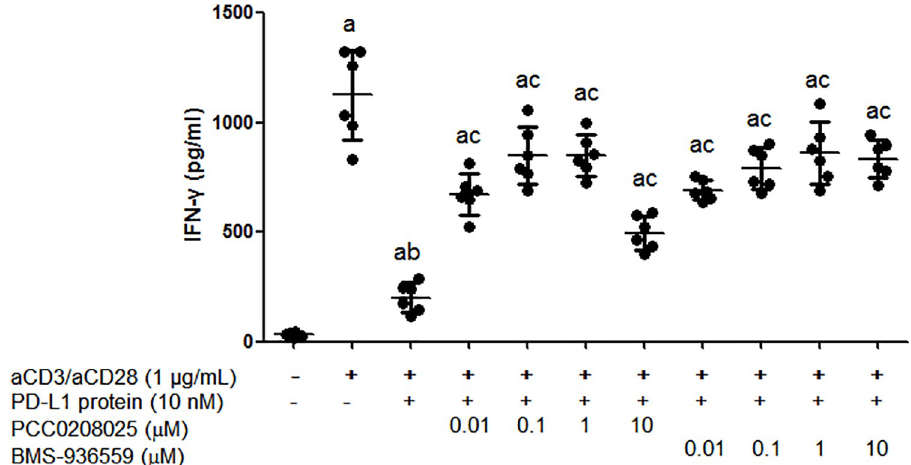
Fig 3. Effects of PCC0208025 on IFN- γ secreted by CD3 + cells in vitro . Human CD3 + cells were plated in the 96-well plate with a density of 1 × 10 5 cells/well in 100 μ L of DMEM containing 10% FBS. The 50 μ L of aCD3 and aCD28 (final concentration of 1 μ g/mL for each) were added into 96-well plate without or with 50 μ L of human PD-L1 protein (final concentation of 10 nM). Then 50 μ L of BMS-936559 or PCC0208025 solution with the final concentrations of 0.01, 0.1, 1 and 10 μ M were added to the wells and cultured for 72 h. The supernatants were collected for detection of IFN- γ by using human IFN- γ ELISA Kit. The results were presented as mean ± SD (n = 6). a P < 0.05 compared with medium control group. b P < 0.05 compared with aCD3/aCD28 control group. c P < 0.05 compared with aCD3/aCD28 and PD-L1